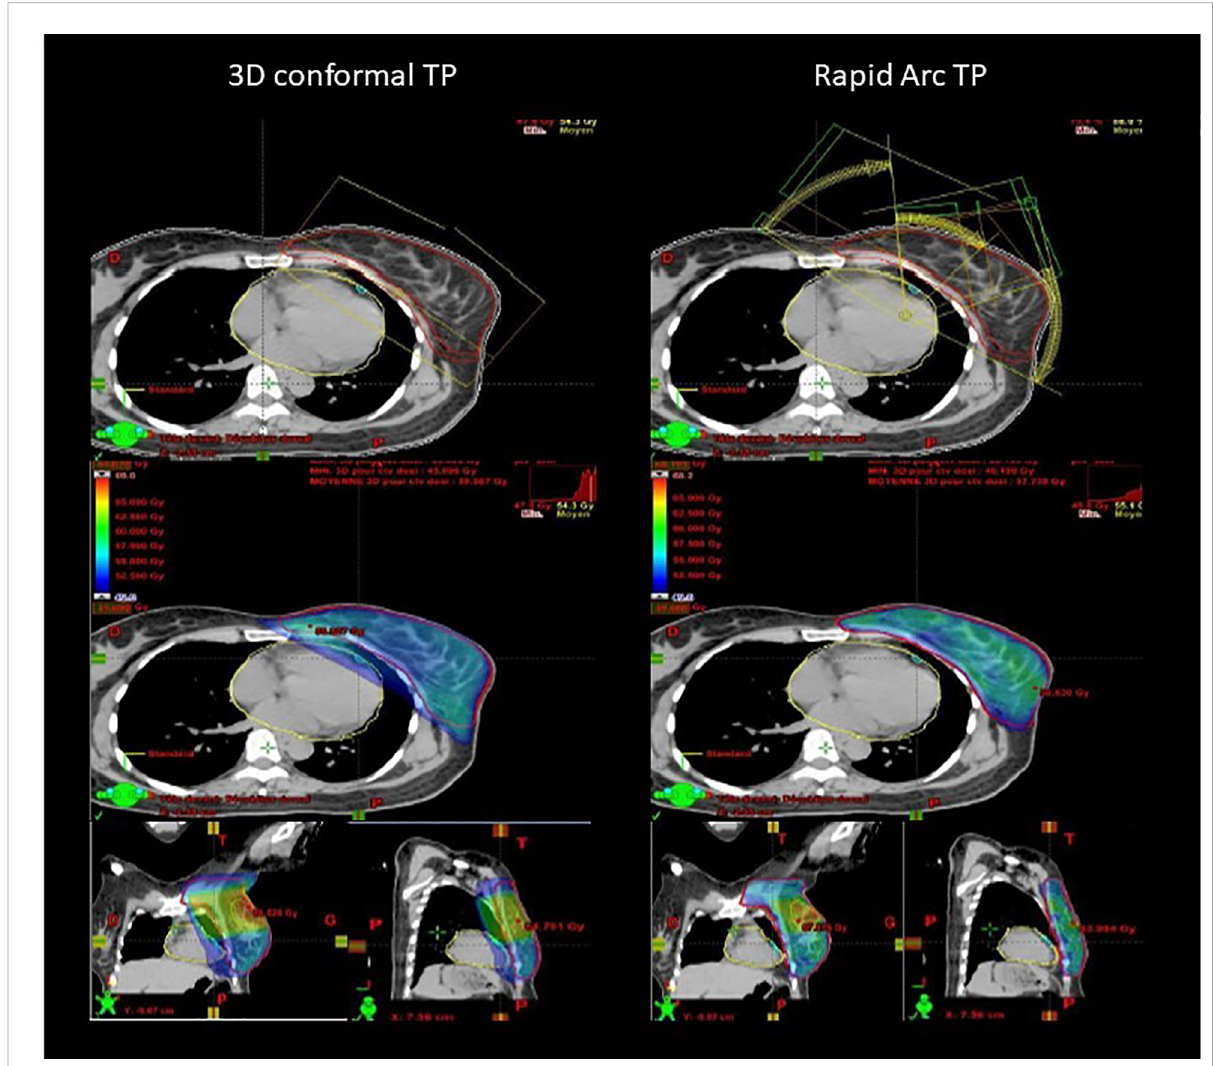
FIGURE 1 Example of comparison of 3D conformal (virtual) radiotherapy plan with tangent fi elds and RapidArc-based IMRT (real) plan with six partial rotation arcs to ensure the same target volume coverage (95% isodose